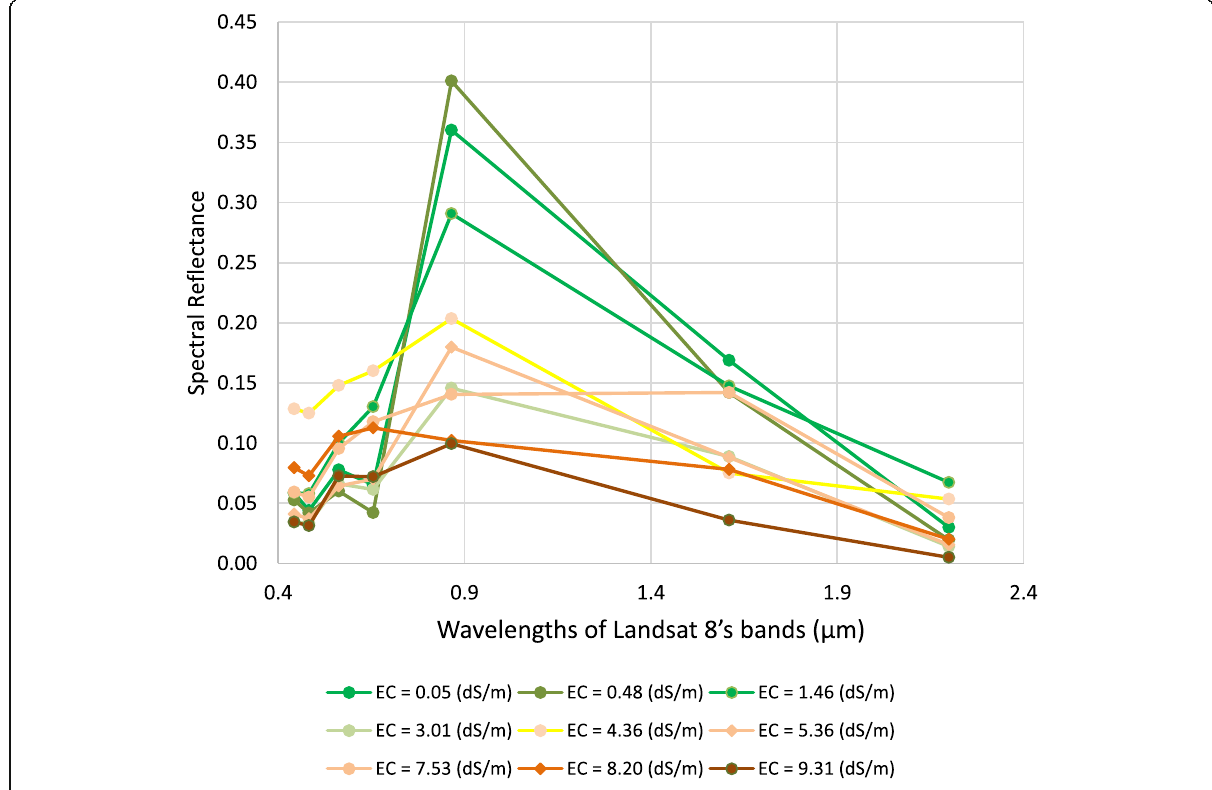
Fig. 7 Spectral reflectance profiles of the major salt-affected lands extracted from Landsat 8 image in the Tra Vinh